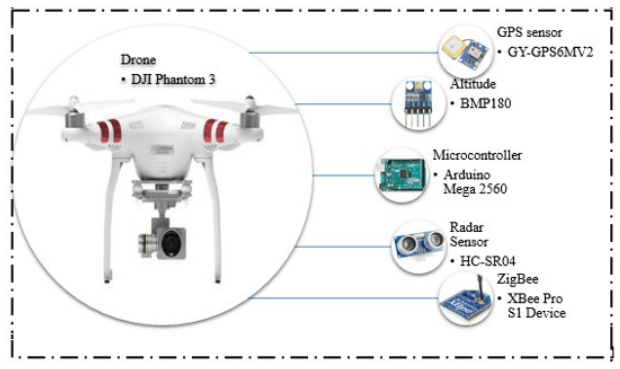
Figure 7. Hardware components of the proposed system.